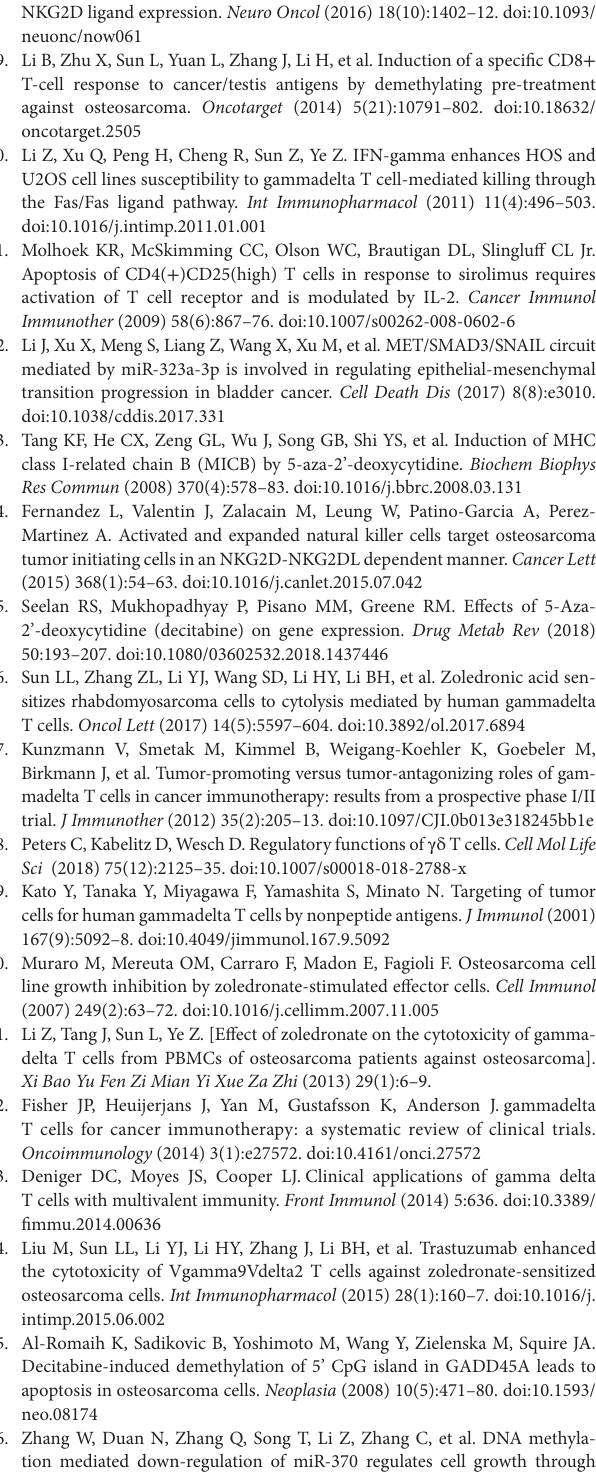
FigUre s1 | Scheme of experimental groups and treatment procedure in vivo . FigUre s2 | The human γδ T cells were identified by their expression of T cell receptor (TCR) and natural killer group 2D (NKG2D) after 5 µM decitabine (DAC) treat ment for 1 day. The percentage of γδ TCR + and NKG2D + γδ T cells was analyzed by flow cytometry and no obvious change was observed between the two